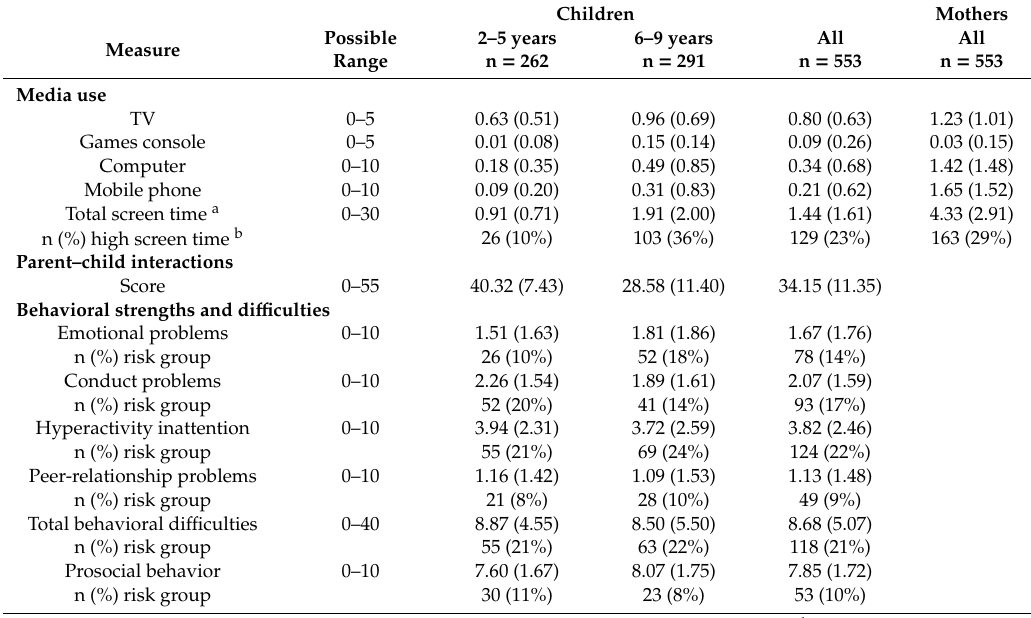
Table 1. Means (and standard deviations) of screen times, parent–child interaction scores, and SDQ scores in the present